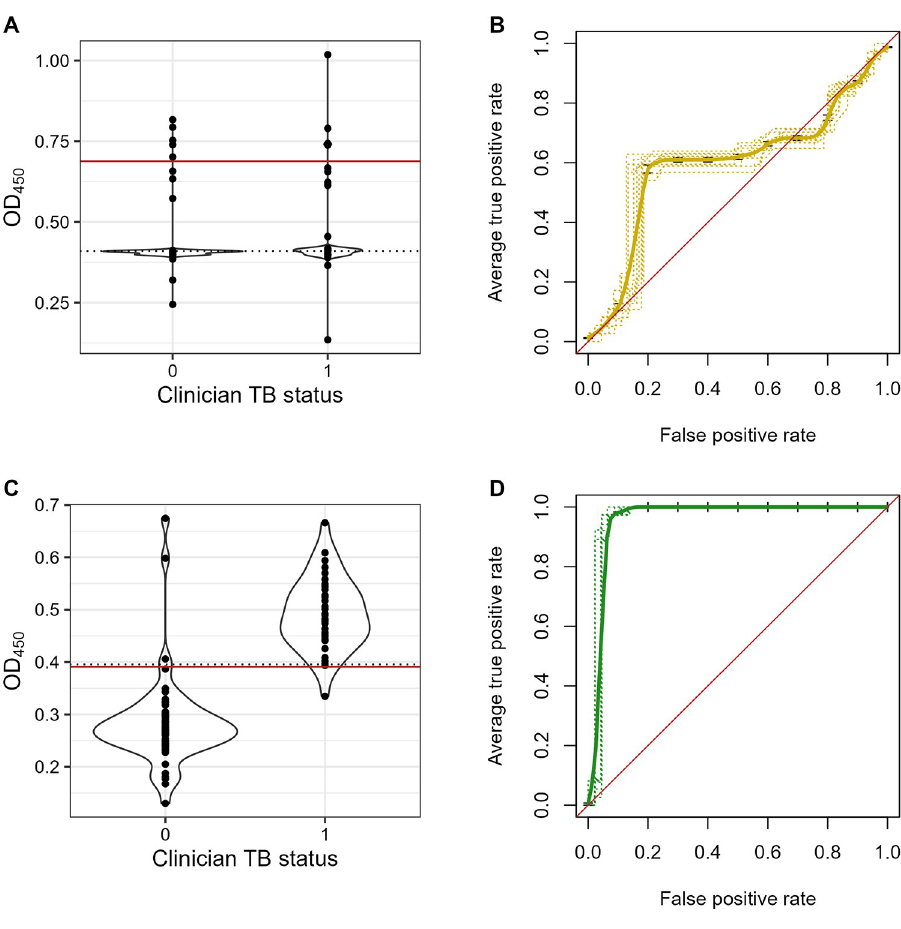
Fig 3. Comparative performance analyses of CS35 vs, BJ76 as capture mAbs in C-ELISA. A: values for mAb CS35 are plotted for each TB status; violin plots indicate the density of points. The cutoff based on a logistic model is shown by the solid red line; the cutoff based on the standard curve is given by the dotted line. The majority of values were at or near the standard curve cutoff. B: Average ROC curve with 10-fold cross-validation curves shown by dotted lines. AUC was low in all folds. C: OD 450 values for BJ76 are plotted for each TB status; violin plots indicate the density of points. The cutoff based on a logistic model is shown by the solid red line; the cutoffs based on the standard curve are shown by the dotted lines. D: Average ROC curve with 10-fold cross-validation curves shown by dotted lines. AUC was high in all folds.